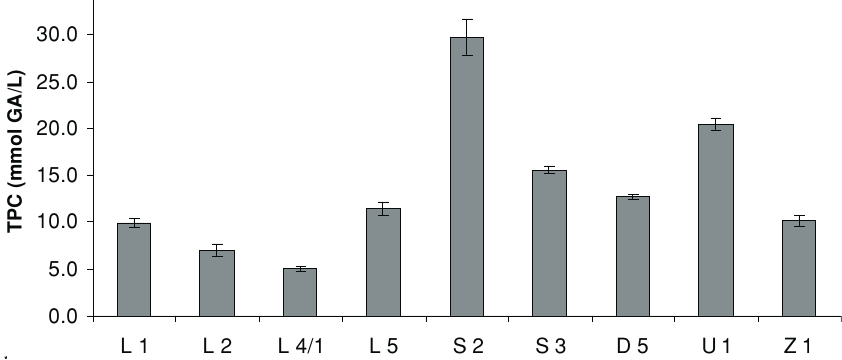
Figure 2. Total phenolics content in fruits of Prunus spinosa and P. insititia selections, collected in 2009, Lövôpetri,